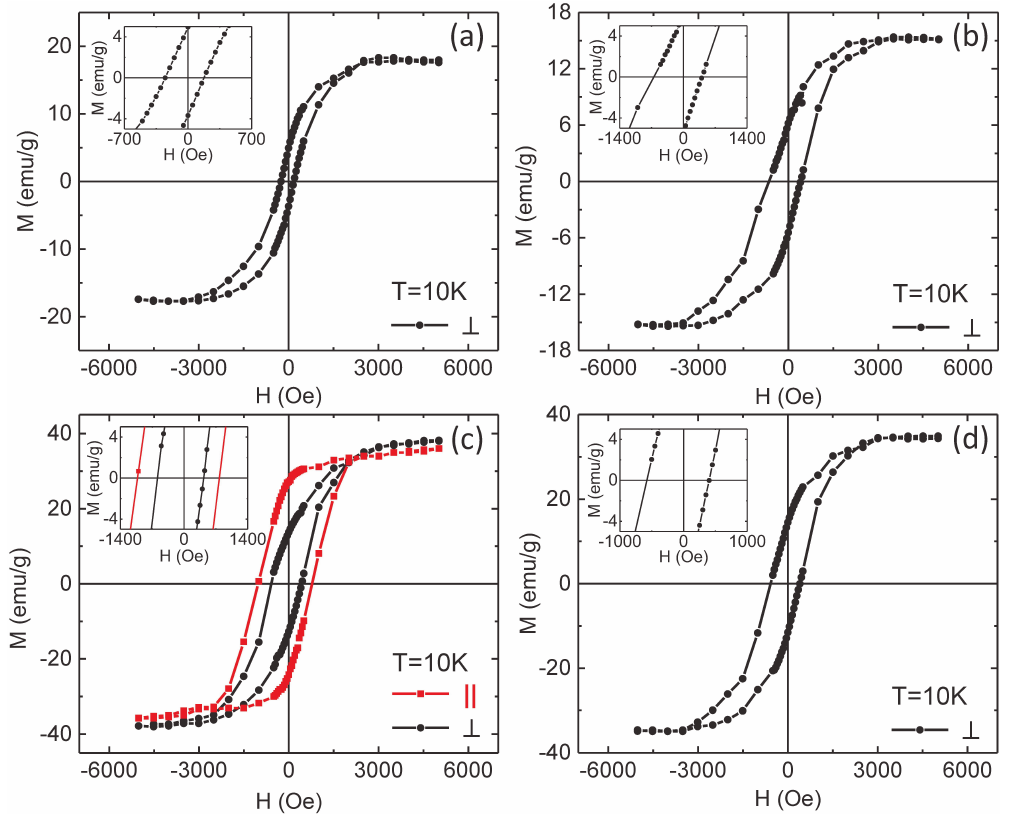
Figure 8. Hysteresis loops of samples S1 ( a ), S2 ( b ), S3 ( c ) and S4 ( d ), recorded at 10 K with the magnetic field applied perpendicular (black lines with dots) and parallel (red line with squares) to the NTs axis, after cooling the samples in a field of 2000 Oe from room temperature. The latter is shown only for S3. The insets represent corresponding closed-up magnifications around the coordinate system’s origin, showing the magnetic coercivity within the prepared